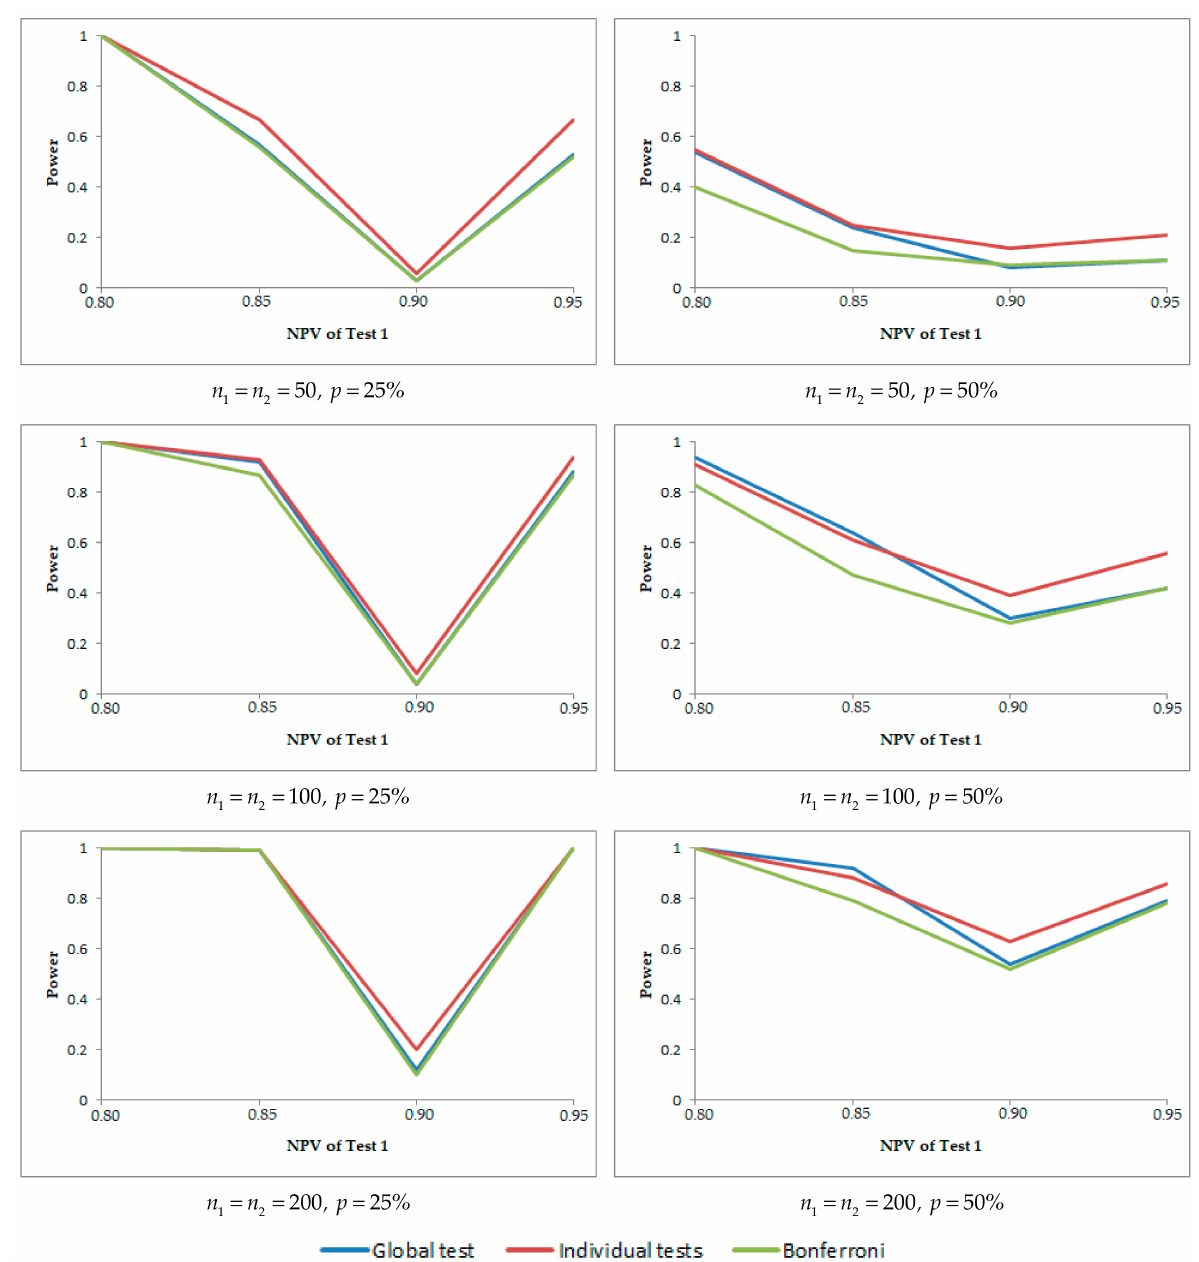
Figure 1. Powers of the three methods when the negative predictive value (NPV) of a binary diagnostic test varies and the rest of the PVs are